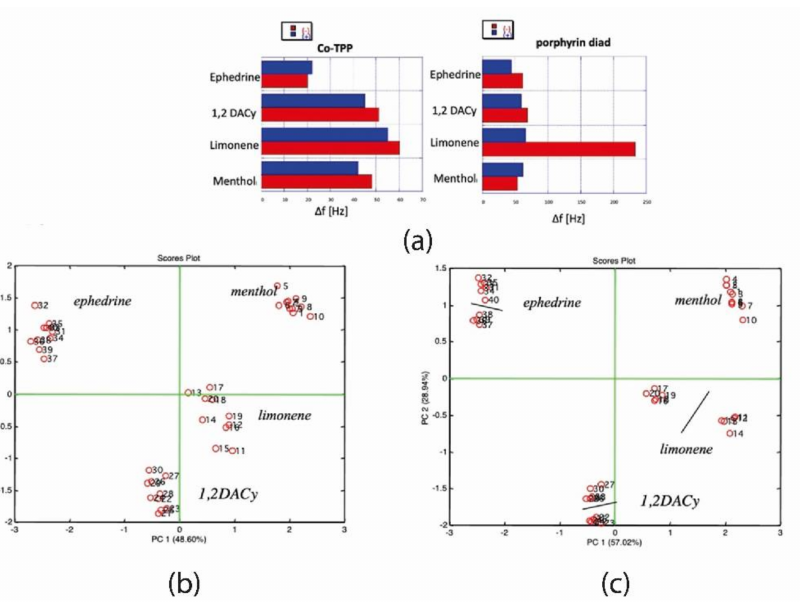
Figure 2. Example of a chiral selective electronic nose. ( a ) Response patterns of QMB coated with CoTPP ( left ) and a chiral porphyrin assembly ( right ). ( b ) Principal Component Analysis (PCA) scores plot of five non-enantioselective porphyrins shows the identification of the four tested compounds. ( c ) PCA scores plot of porphyrins coated QMB at which a chiral selective sensor is added. Except for menthol, the clusters of compounds split into the two enantiomers. (Unpublished results by C. Di Natale et